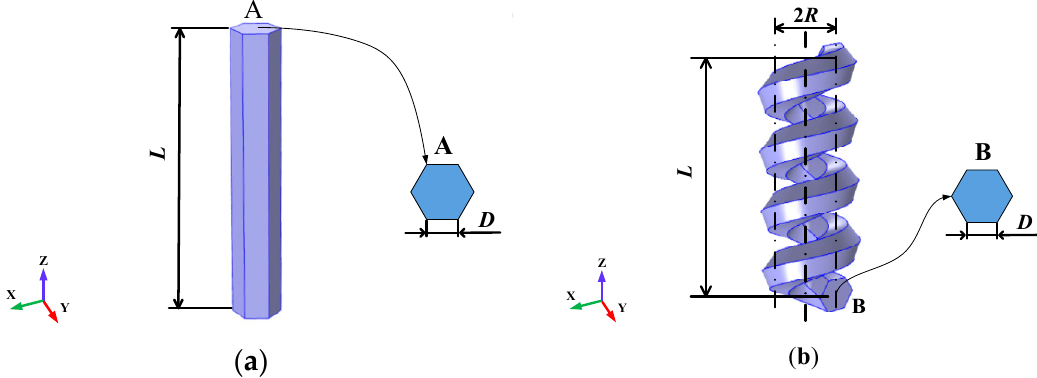
Figure 1. Schematic illustration of ( a ) ZnO nanowire and ( b ) ZnO nanohelix. Both nanostructures have a hexagonal cross-section with the same side length D and height L . The nanohelix has a number of coils T and a mean radius of coil R .